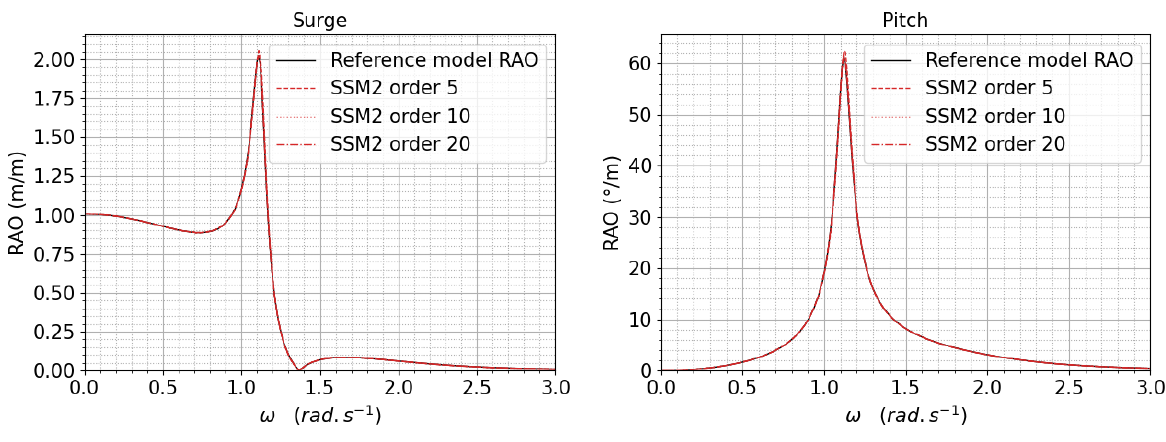
Figure 6. Comparison between SSM2 and the reference RAO for surge and pitch